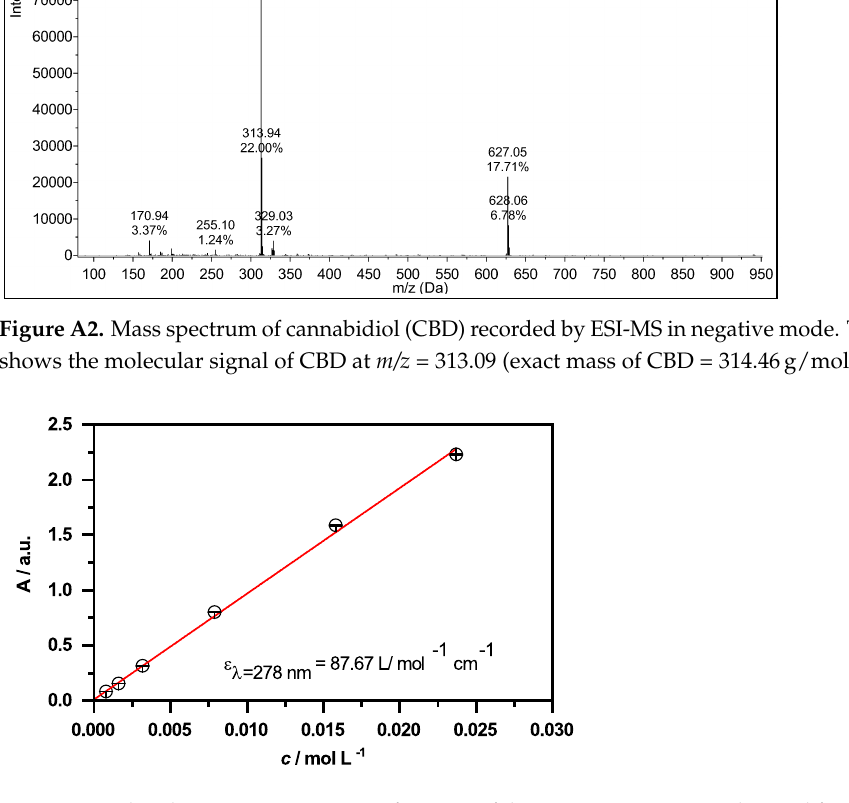
Figure A3. Absorbance at λ = 278nm as function of the CBD concentration obtained from the UV/Vis measurements. The extinction coefficient is obtained from the slope of the linear fit (red line).